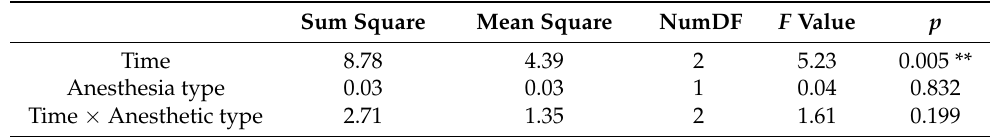
Table 4. Interaction model of sample time and anesthesia